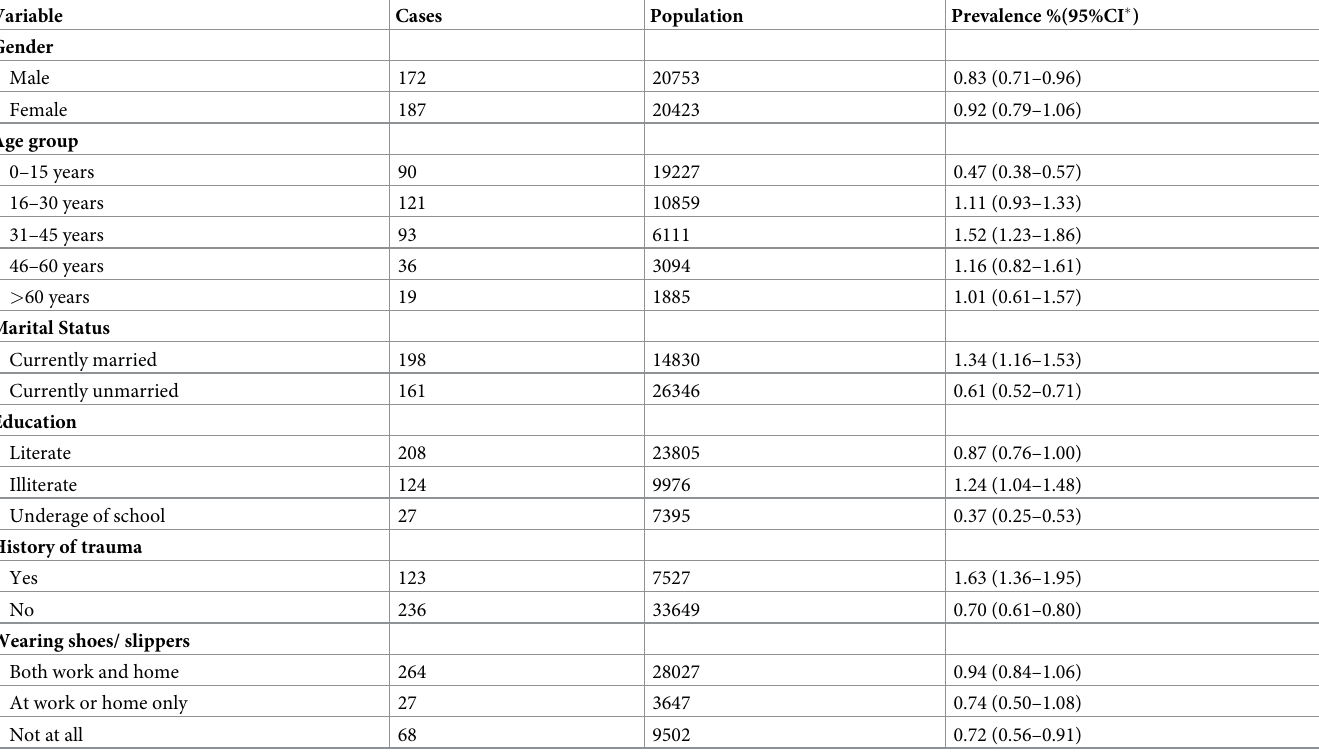
Table 2. Prevalence mycetoma patients (N = 359) among the studied individuals (41,176) in Eastern Sennar locality, Sennar State,